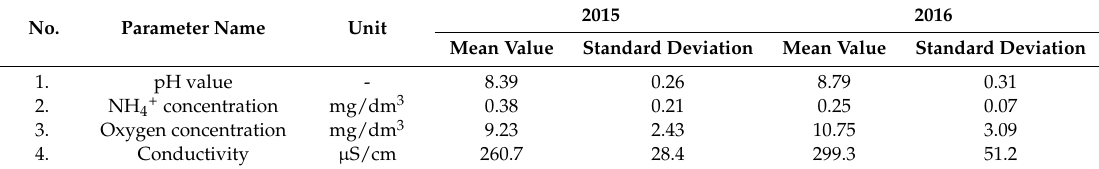
Table 2. Selected water quality parameters in the north part of the Sulejow Reservoir between April– October 2015 and 2016.